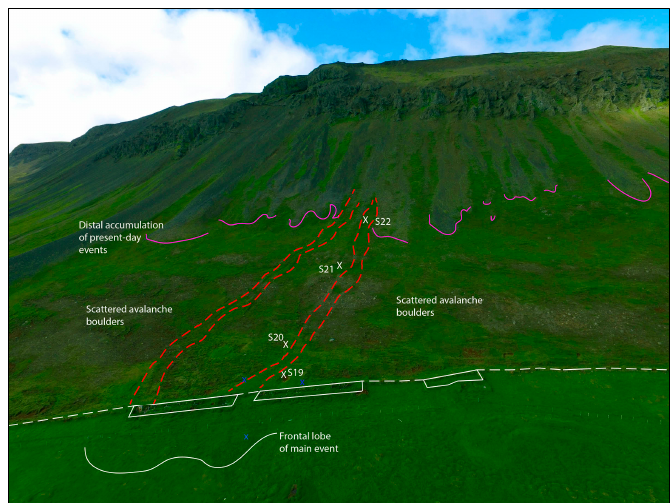
Figure 4. Aerial view of the western part of the Flautafell farmland and the slope above. The dashed red line shows the trajectory of the two channels originating between avalanche boulder tongues and heading towards the farm. The extent of active avalanche boulder tongues is delineated in pink, farm outbuildings are represented by a solid white line, and the homefield wall is shown by a dashed white line.